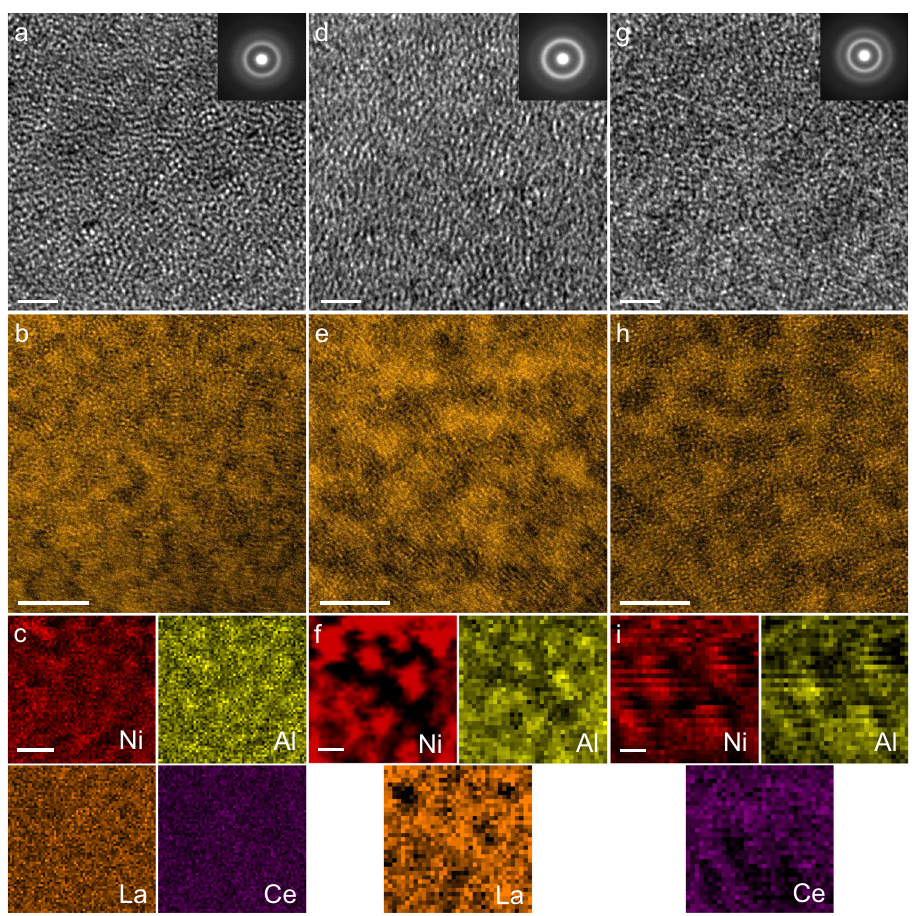
Fig. 3 The atomic structures and corresponding elemental distributions of the La(Ce)NiAl system. a , d , g HRTEM images presenting uniform mazelike patterns for the as-cast LaCe-HEMG, La 55 Ni 20 Al 25 , and Ce 55 Ni 20 Al 25 , respectively, the corresponding SAED patterns (insets) demonstrating the typical amorphous structures. Scale bars: 2 nm. b , e , h HAADF-STEM images of LaCe-HEMG, La 55 Ni 20 Al 25 and Ce 55 Ni 20 Al 25 , respectively. Scale bars: 5 nm. c , f , i Corresponding EDS chemical mappings for LaCe-HEMG, La 55 Ni 20 Al 25 and Ce 55 Ni 20 Al 25 , respectively. LaCe-HEMG exhibits relatively homogeneous elemental distributions. Scale bars: 5